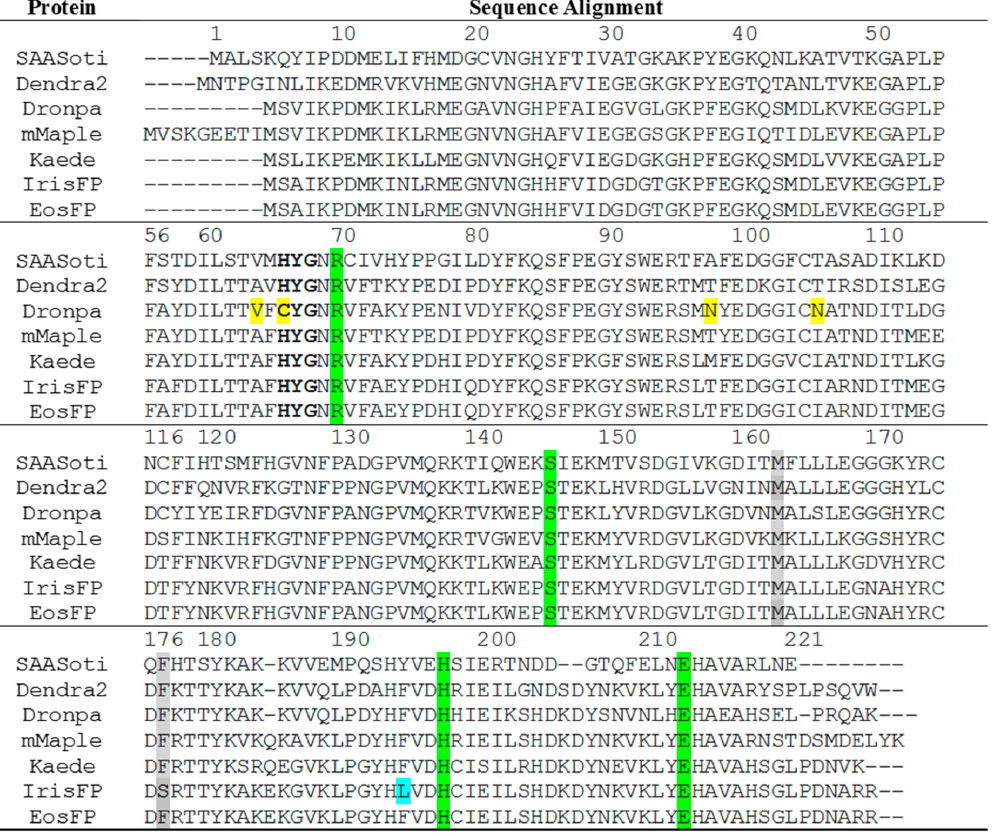
Figure 1. SAASoti sequence alignment with other phototransformable fluorescent proteins (SAASoti numbering). Yellow – Dronpa to pcDronpa mutation points; grey – critical points for photoswitching appearance in case of EosFP; Dendra2; green – ‘off’-state stabilization points.